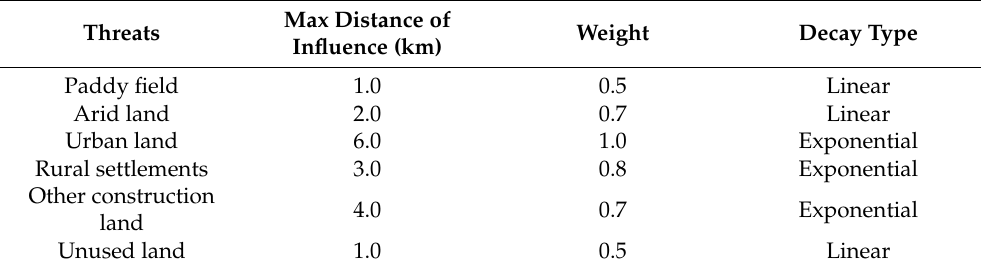
Table 2. Threat factors and their maximum distance of influence, weight, and type of decay over space.